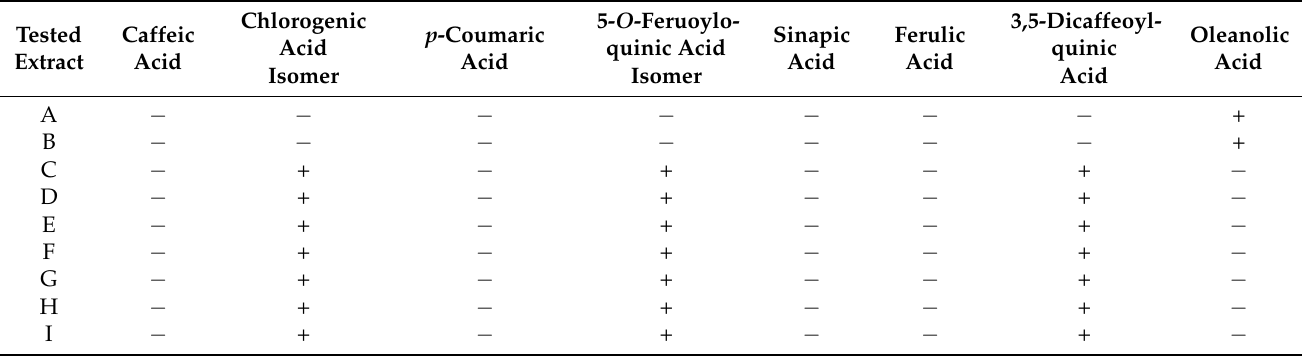
Table 2. HPLC-PDA-ESI-MS analysis of hairy root extracts based on standard compounds used in present